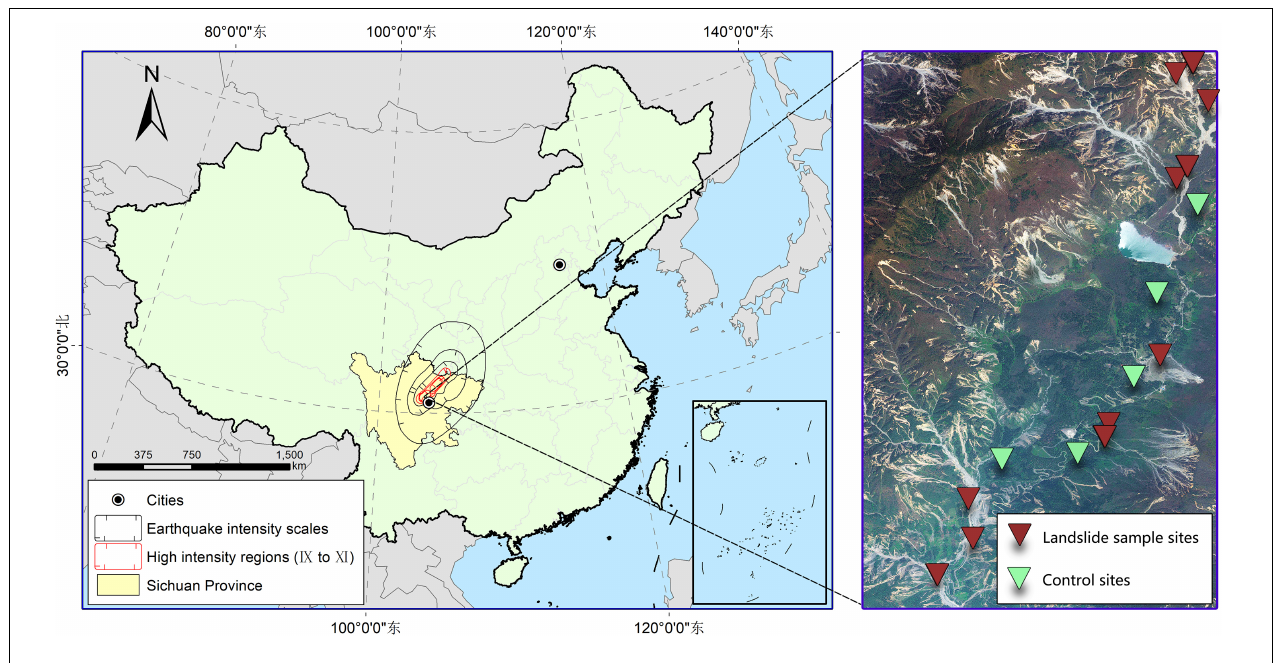
FIGURE 1 | Study area and sample